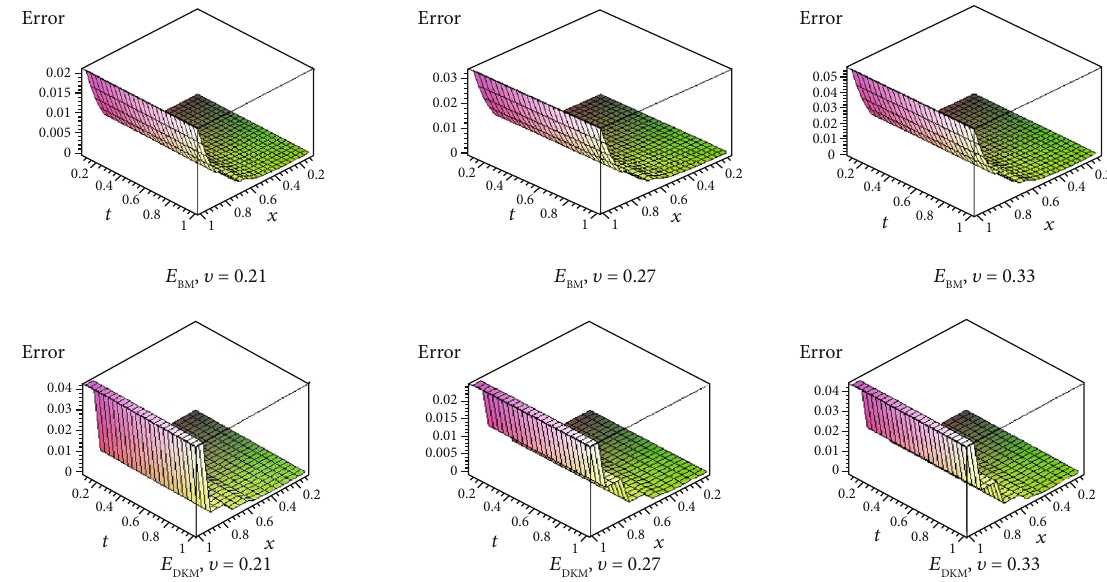
Figure 6: The values of errors by B-by- BM and DKM at T = 1 , N = 20 , and k = 1 for υ = 0 : 21, 0 : 27, 0 : 33